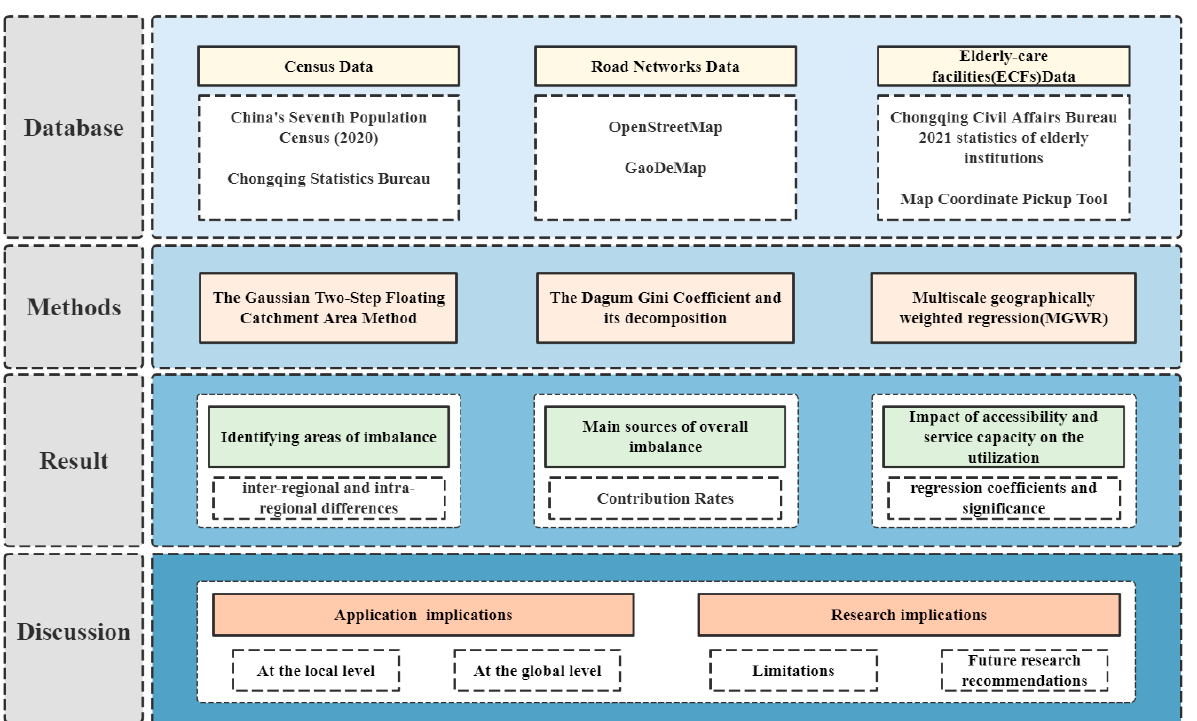
Figure 1. Research framework.